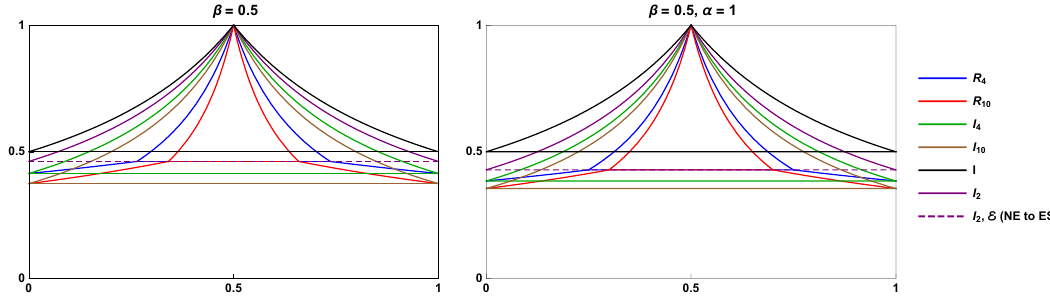
Figure 8 . Phase transition lines for R n and I n for a few different n for f B as in (4.58) and (4.59) are shown on the left and right respectively.